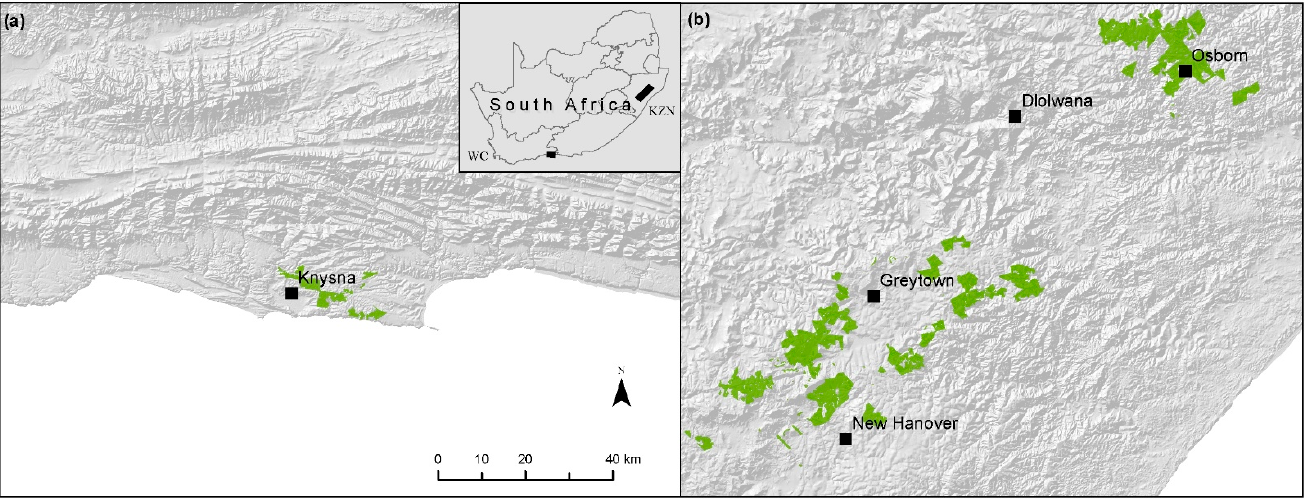
Figure 2. Locations of Study Area 1 ( a ), along the southern coast of the Western Cape (WC) province, and Study Area 2 ( b ), in the KwaZulu-Natal (KZN) midlands Study Area 1 receives ~875 mm of rainfall per annum, with peak rainfall during July.